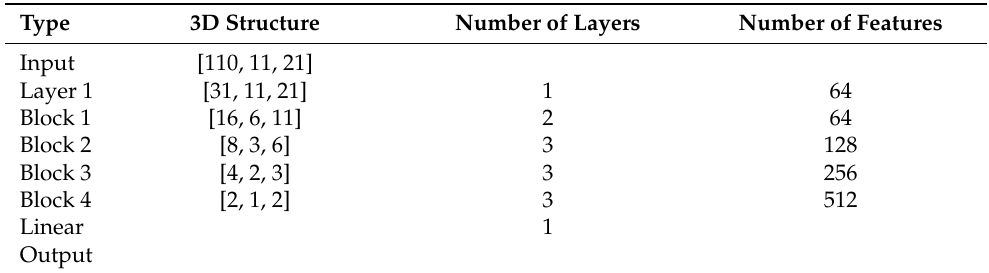
Table 1. The ResNet10 overall structure, using customary ResNet